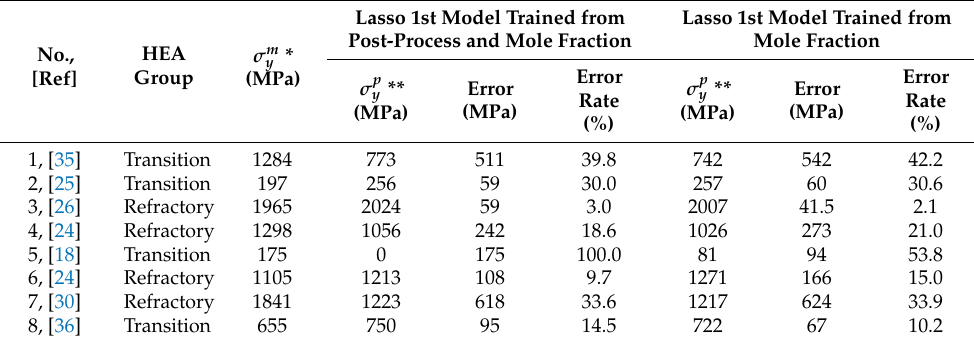
Figure 5. Accuracy of a lasso model trained only on elemental mole fractions. Table 5. Comparison of the predicted results data calculated by the lasso linear model, which was trained by post-process and mole fraction data vs. mole fraction data.